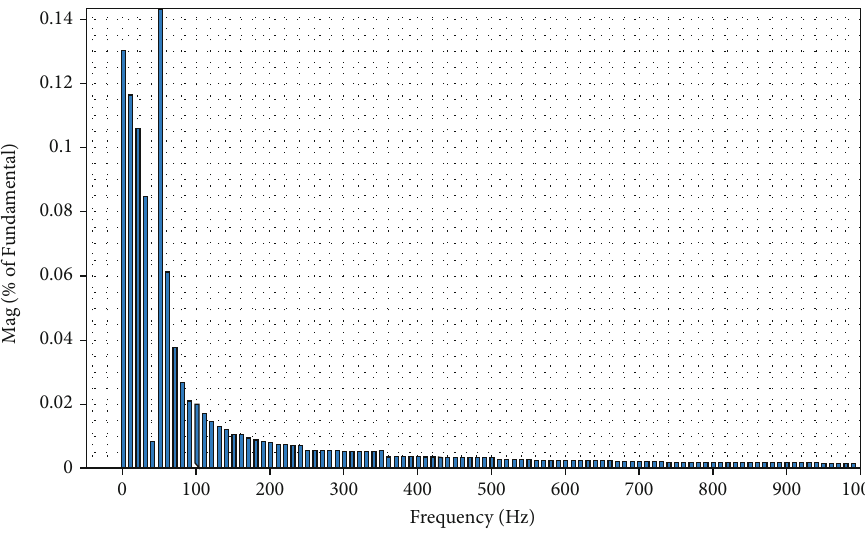
Figure 38: THD values of microgrid load current.